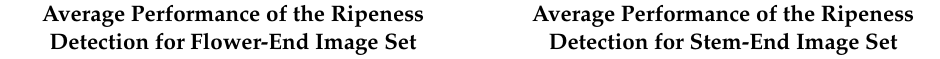
Table 3. Tomato ripeness detection performance reported by five-fold cross-validation based on YOLOv3.